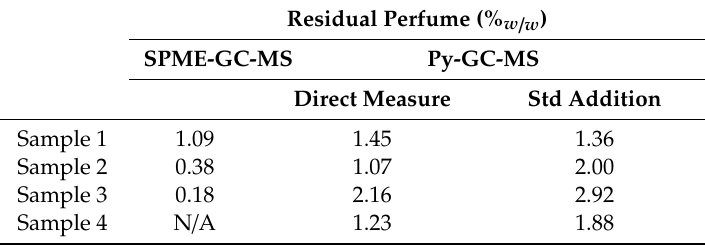
Figure 7. Standard addition quantification of Romascone ® (pink), Verdox TM (green), Lorysia ® (light blue), Cyclosal (orange), Salicynile ® (blue) and the corresponding overall perfume (black) by Py-GC-MS for Sample 1 (upper left), Sample 2 (upper right), Sample 3 (lower left) and Sample 4 (lower right). Table 2. Quantification of residual perfume in shells samples 1–4 using SPME-GC-MS and